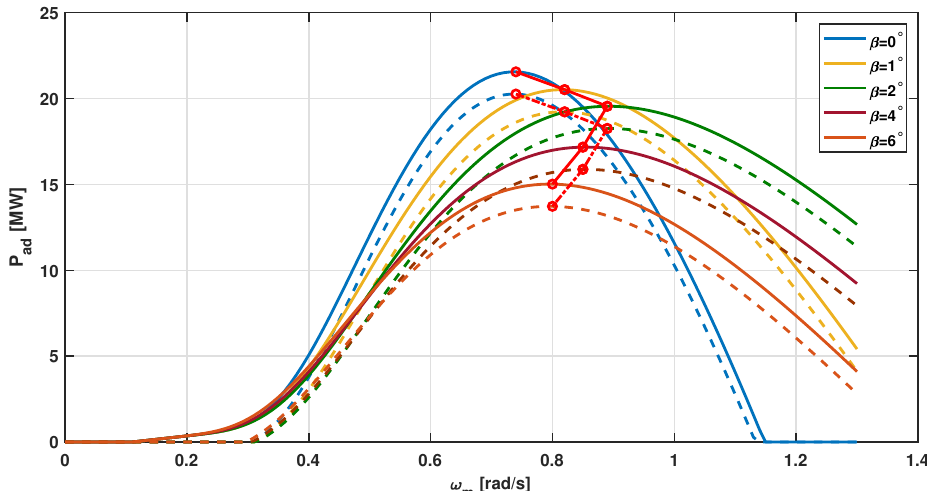
Figure 12. Analytical results of P ad − ω m corresponding to different blade pitch angles β b .